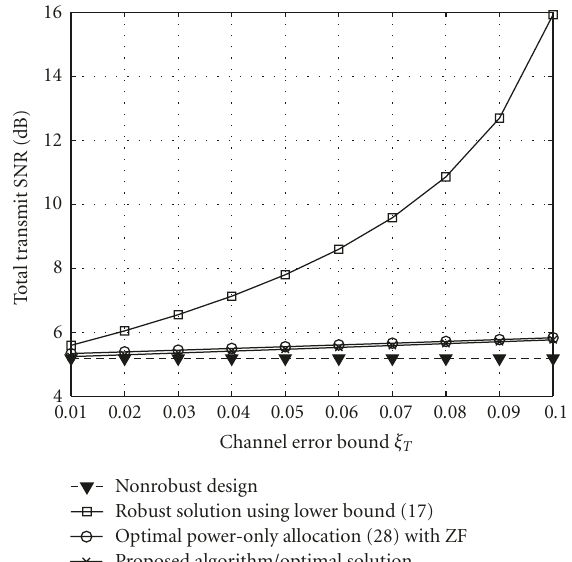
Figure 3: The total transmit SNR versus the channel error bound for a 3-user (3,1) system.